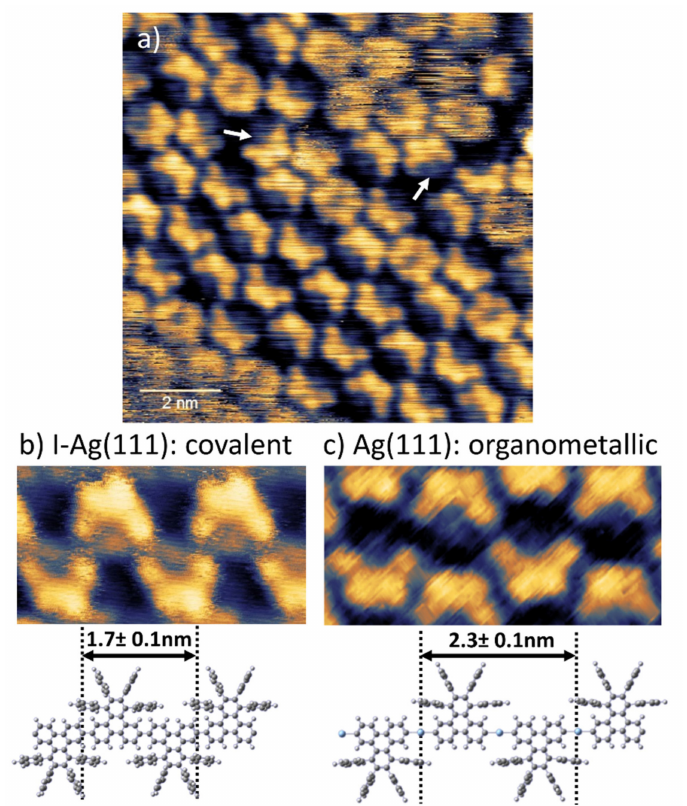
Figure 3. ( a ) STM image of organometallic chains and smaller entities observed upon deposition via the RaDeS onto pristine Ag(111). The white arrows highlight individual monomers. Comparison of both ( b ) covalent and ( c ) organometallic chains as obtained on I-Ag(111) and Ag(111), respectively. The corresponding molecular structures with their respective repeat distances are shown